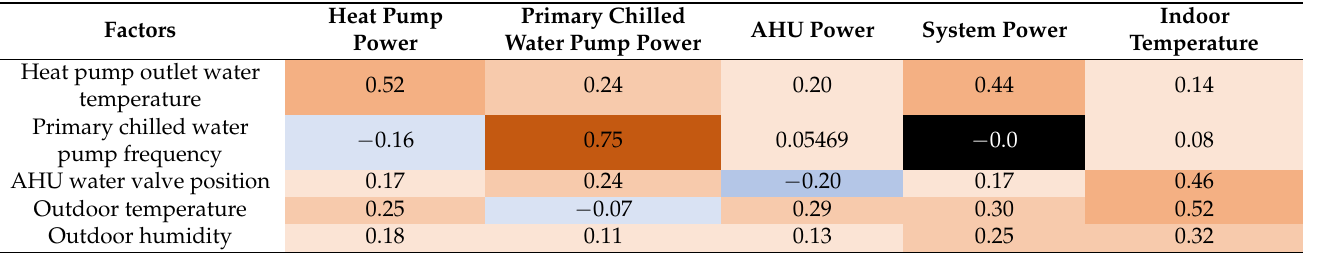
Table 3. Partial correlation coefficient among system